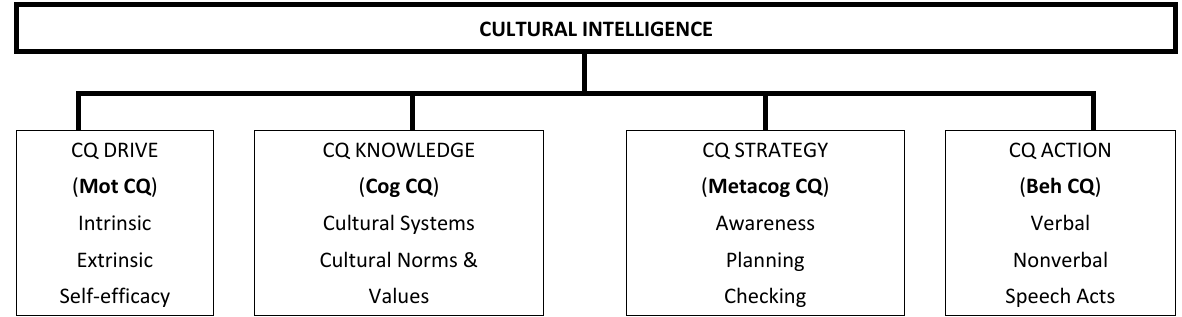
Figure 1. Four-dimensional model of cultural intelligence. Source: Livermore (2015).